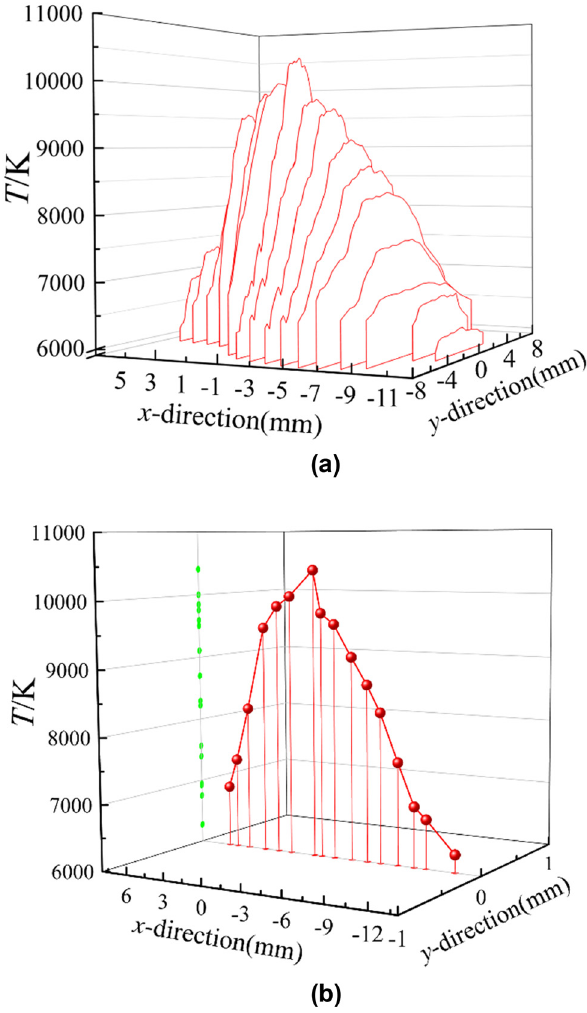
Figure 7: Temperature distribution of arc current - carrying region in sheet slanting electrode tungsten inert gas welding. ( a ) Temperature distribution of the arc section. ( b ) Temperature distri - bution in x - direction arc current - carrying